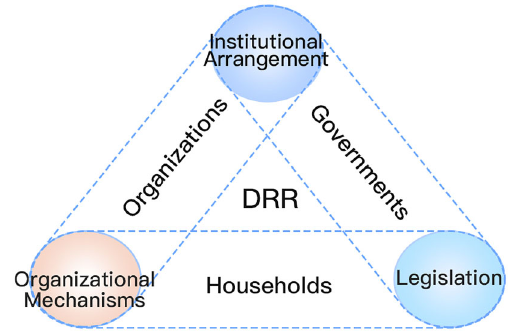
Fig. 5 Collaborative paradigm for regional disaster risk governance: stakeholders’